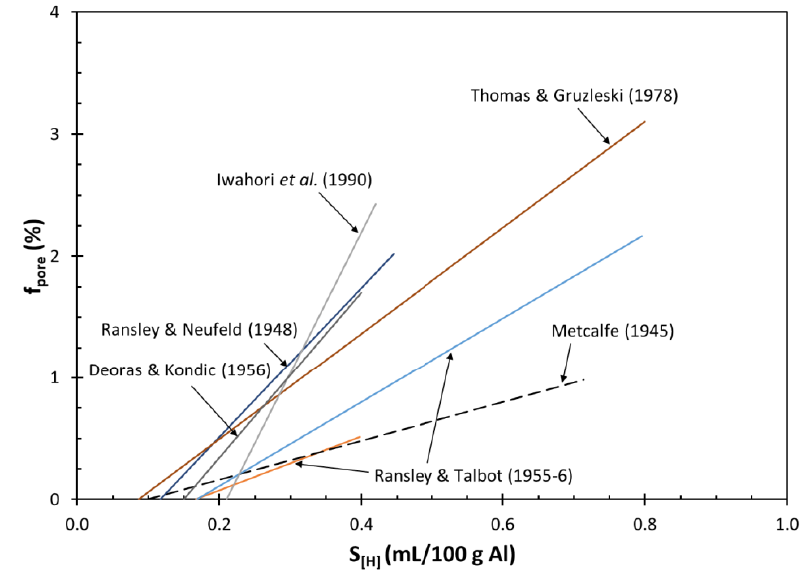
Figure 6. The change in pore volume percent with hydrogen content in the melt from various studies on aluminum castings replotted following the threshold hydrogen concept proposed by Thomas and Gruzleski [69].